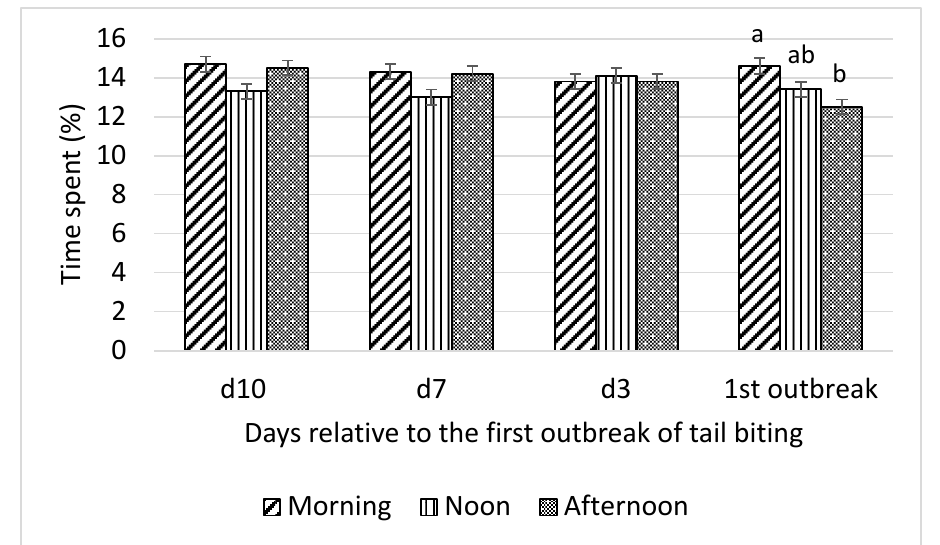
Figure 7. Interaction between day (10 d, 7 d, and 3 d before and during) relative to the first outbreak of tail biting